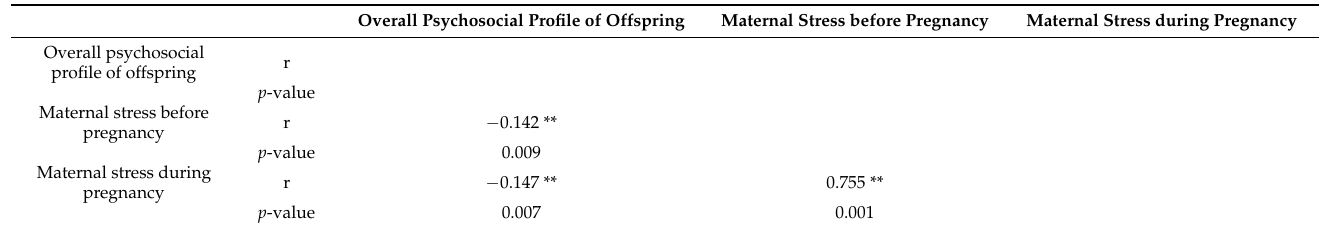
Table 5. Correlation between maternal stress and psychosocial skills of offspring (n = 339). Overall Psychosocial Profile of Offspring Maternal Stress before Pregnancy Maternal Stress during Pregnancy Overall psychosocial profile of